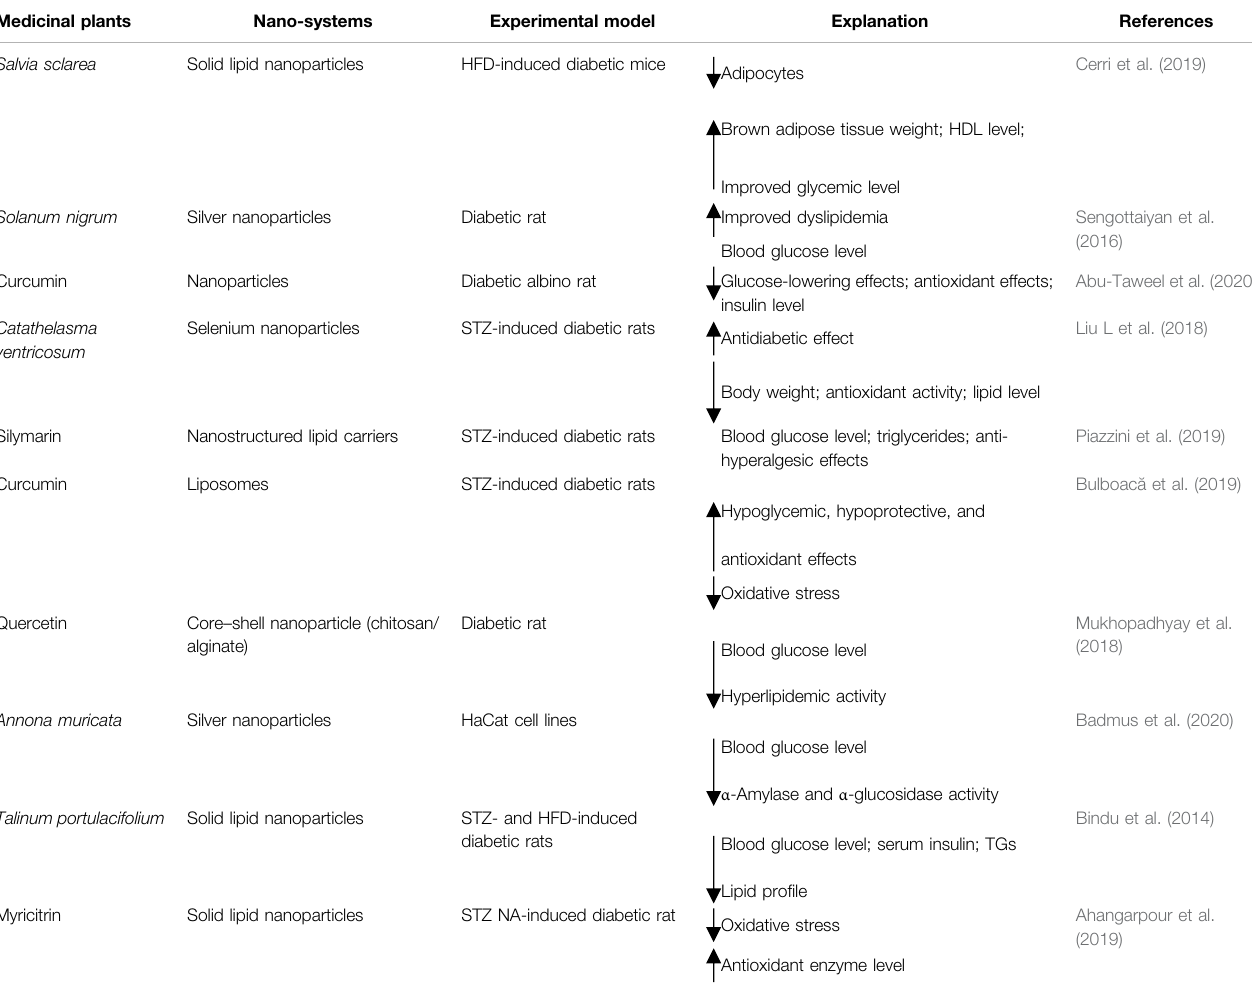
TABLE 1 | Plant extract-based nanosystems for treatment of